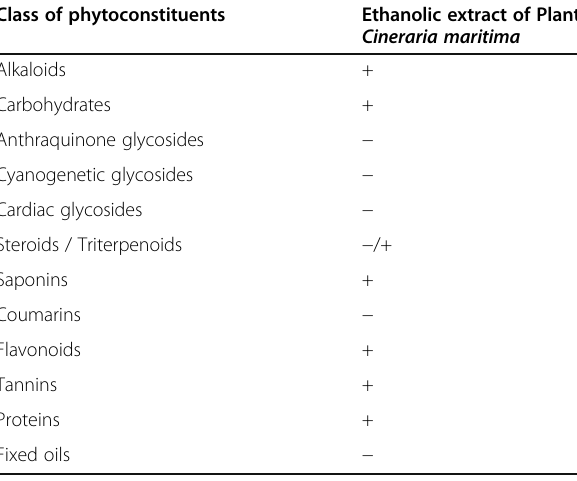
Table 1 Preliminary phytochemical analysis of ethanolic extract of plant Cineraria maritime